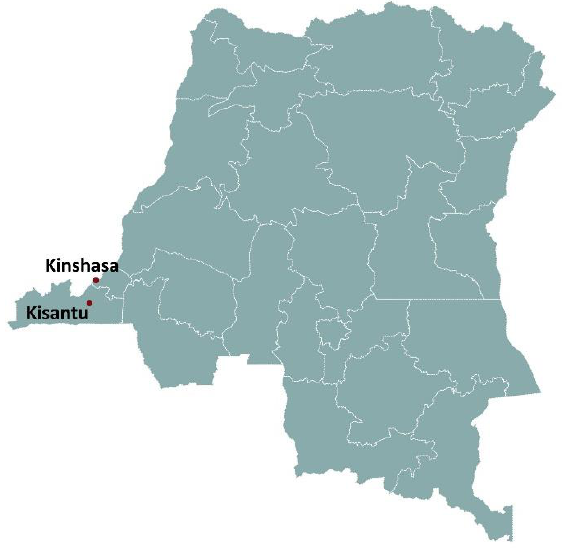
Figure 2. Geographical location of Kisantu hospital in DR Congo.